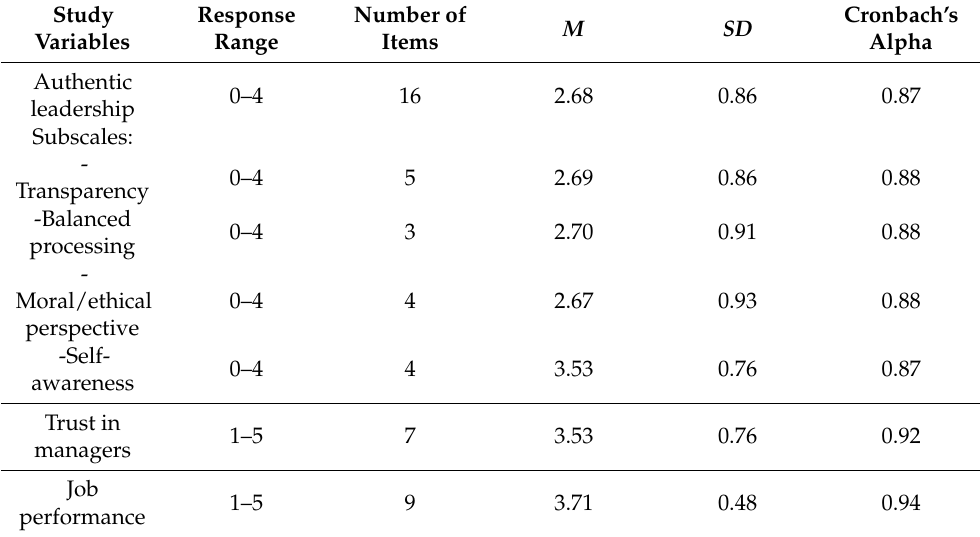
Table 2. Means, standard deviations, and reliability analysis of study variables.